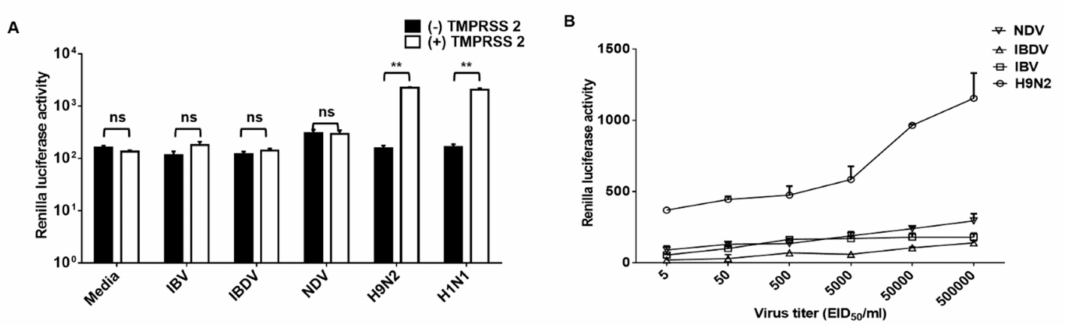
Figure 4. Nanoparticle fusion induced by authentic influenza virus. ( A ) Nanoparticles were incubated with avian influenza virus (H9N2 and H1N1) or avian respiratory viruses (NDV, IBV, and IBDV) for 1 h at 4 ◦ C. ( B ) H9N2, NDV, IBV, and IBDV were 10-fold serially diluted and then incubated with nanoparticles for 1 h at 4 ◦ C. In all experiments, mixtures were adjusted at pH 5.0 and incubated with RL substrate for 10 min. Nanoparticle fusion was quantified by measuring RL activity. Error bars present SD from the mean ( n = 3). Statistical significance was assessed by Student’s t test. **, p < 0.01; ns, not significant.